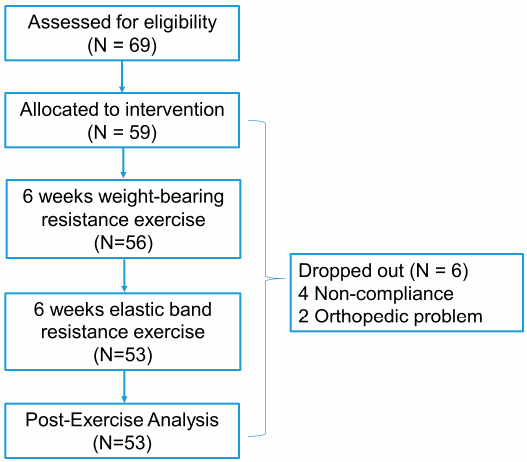
Figure 2. Study flow chart for 12-week exercise program.